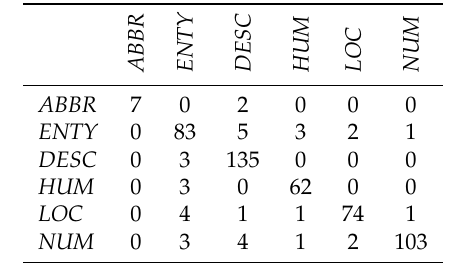
HumNN’s and confusion matrices on Question Classification dataset (after human knowledge